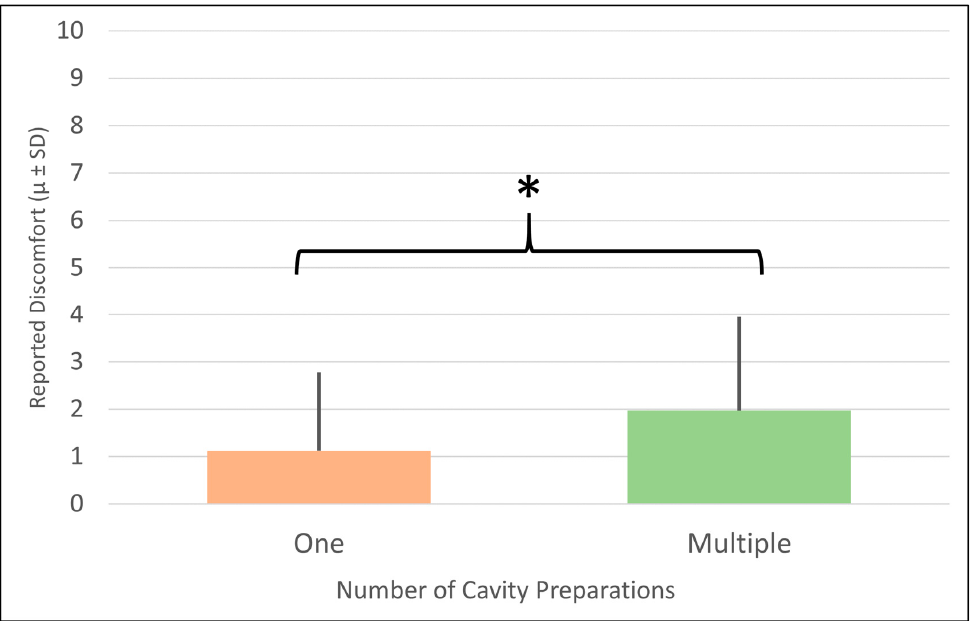
Figure 1. Discomfort reported for participants receiving one versus multiple preparations. 0 = “no discomfort,” 10 = “extreme discomfort”, * p -value < 0.05.